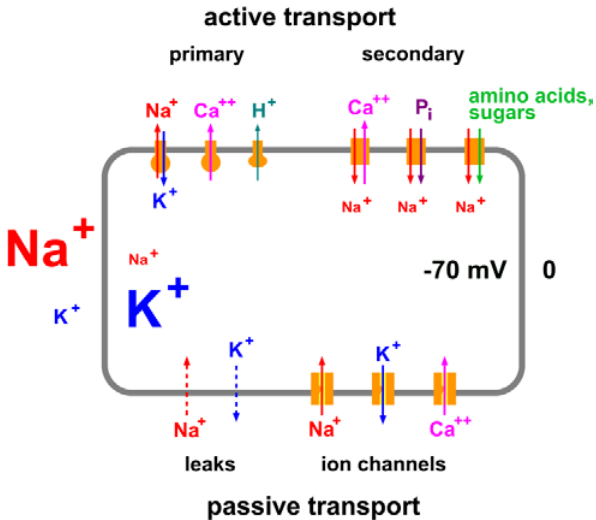
Figure 1. Ion transport pathways in animal cells. Common to all cells is the inside negative electric potential and the ion-concentra- tion gradients oppositely oriented for Na + and K + , with high Na + concentrations outside and low in cytoplasm and vice versa in the case of K + . In principle, two different categories of transport mecha- nisms have to be discriminated, active and passive transport. The active transport is split into primary and secondary active trans- port. In primary active transport so-called ion pumps utilize ATP as energy source to translocate ions “uphill”, i.e. against their elec- trochemical potential gradient. Secondary active transport is per- formed by antiporters (e.g. the Na,Ca-exchanger) or cotransporter (e.g. the Na,P i - or Na,glucose-cotransporter) which translocate one of their substrates “uphill” while the other substrate, usually Na + , provides the necessary free energy by its transport